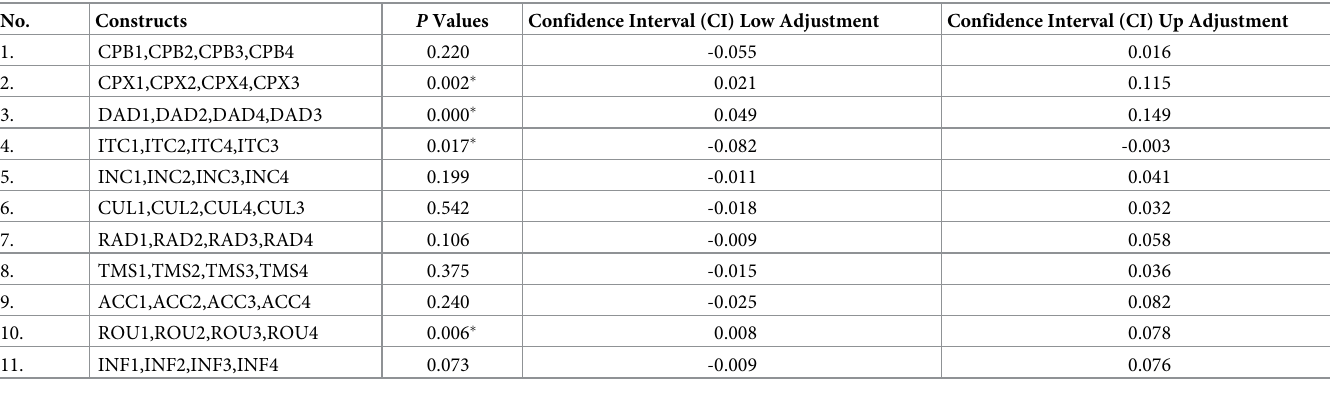
Table 4. Confirmatory Tetrad Analysis (CTA) result.